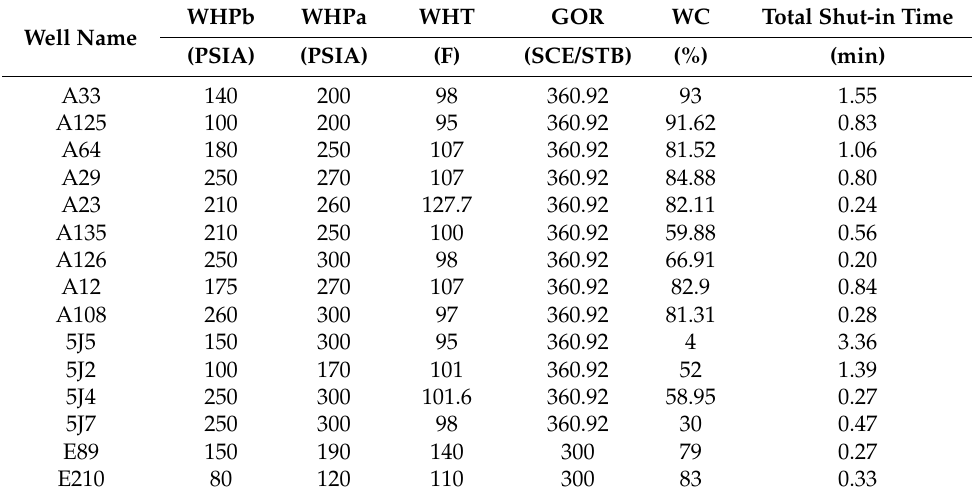
Table 1. Well and physical properties of the fluid.